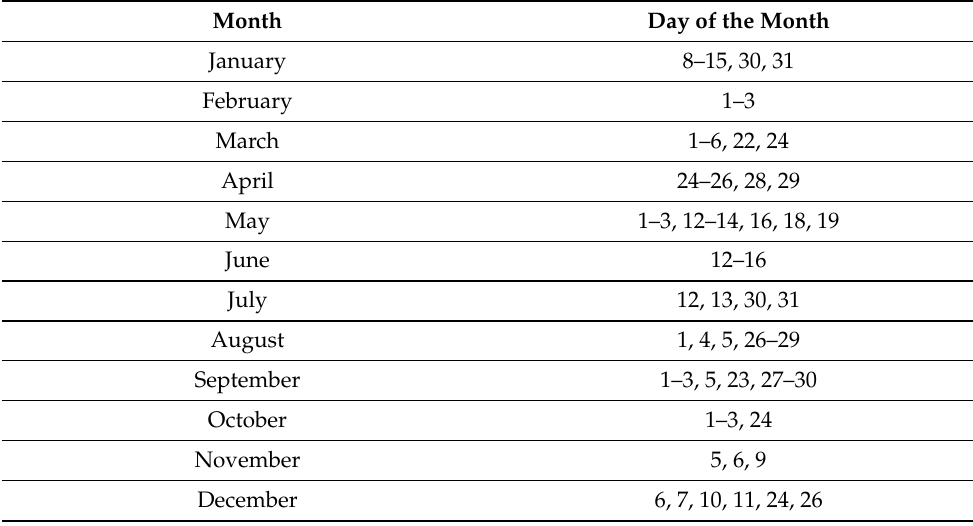
Table 4. Days with large variability of O 3 aCCFs in the year